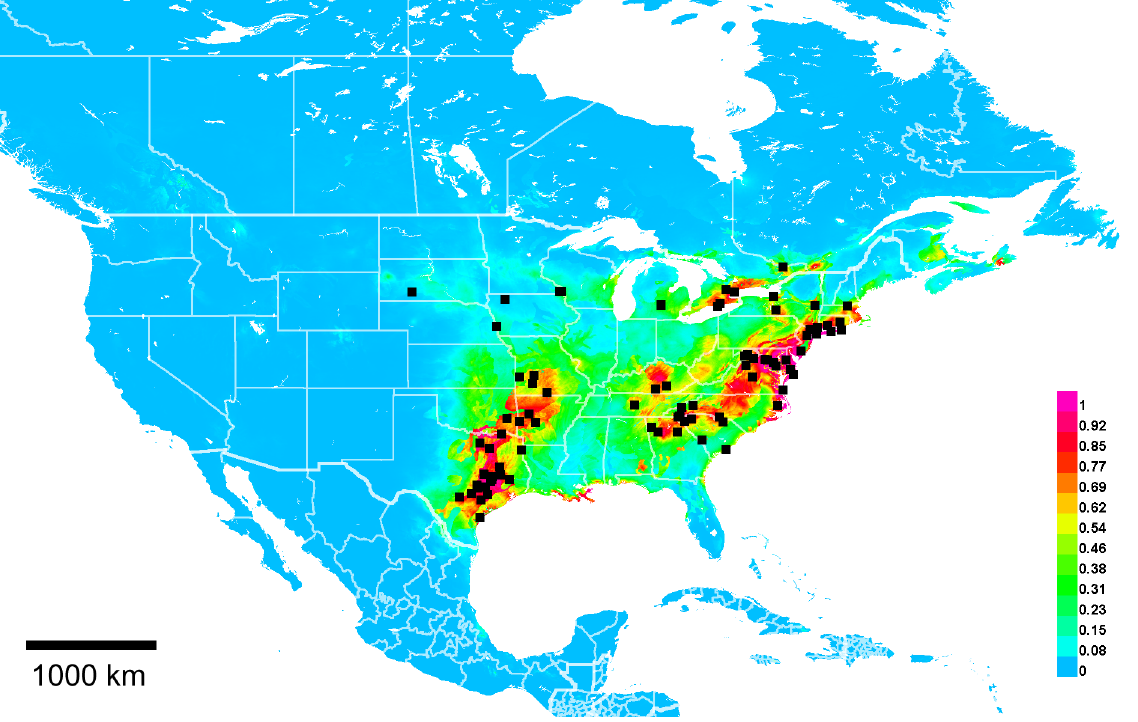
Fig. 72. Georeferenced collection records of Lasioglossum ( D .) tegulare (Robertson, 1890) (black squares) and predicted distribution by maximum entropy ecological niche modelling in Maxent (colour shading). Warmer colours indicate higher cloglog probability of